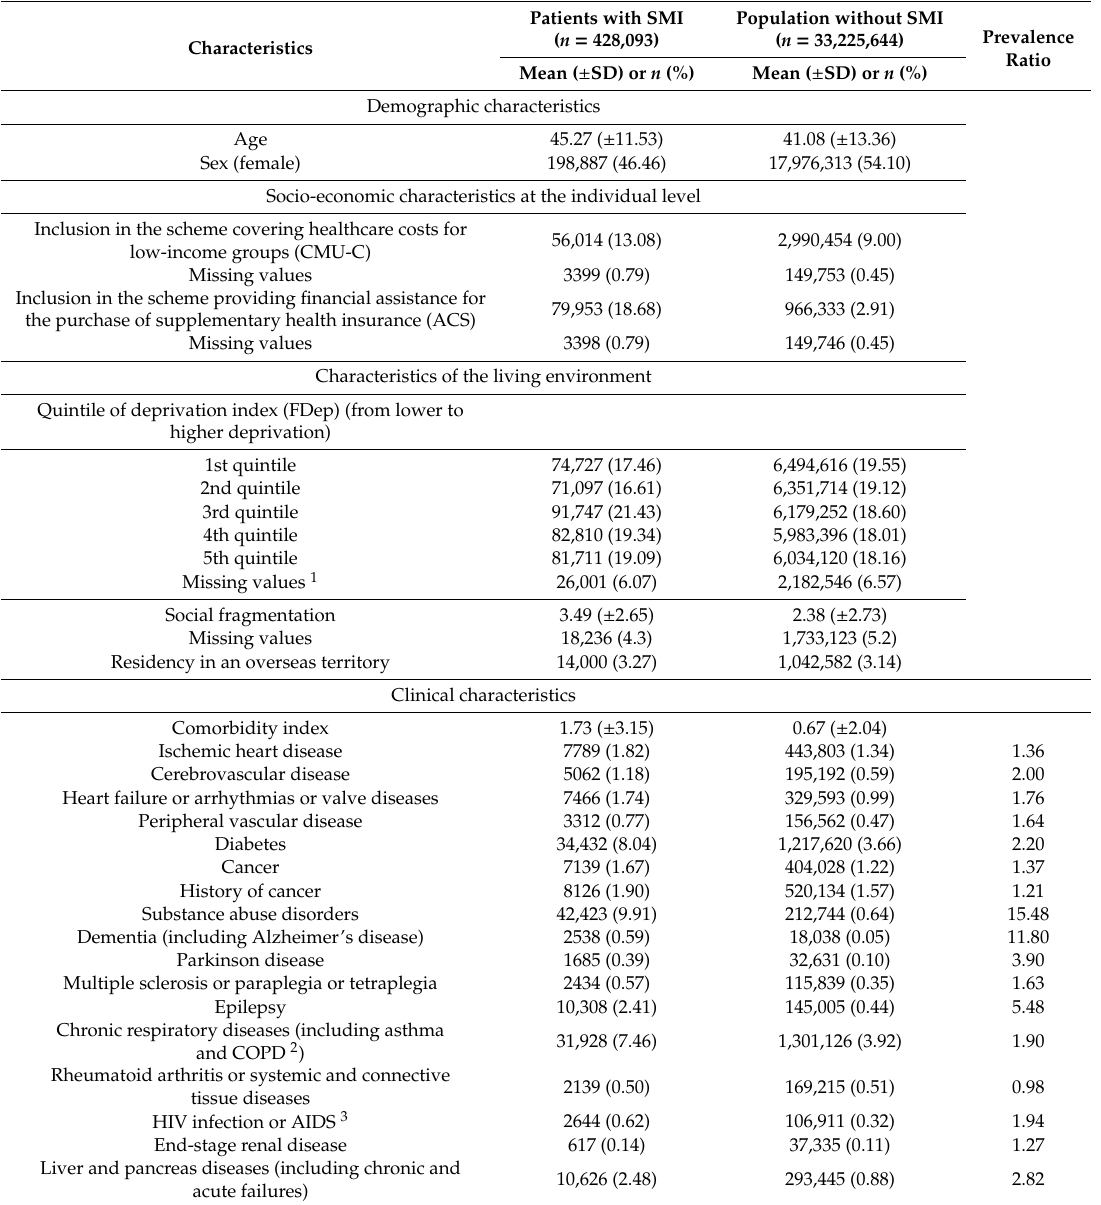
Table 1. Main characteristics of SMI patients and of the population without SMI.